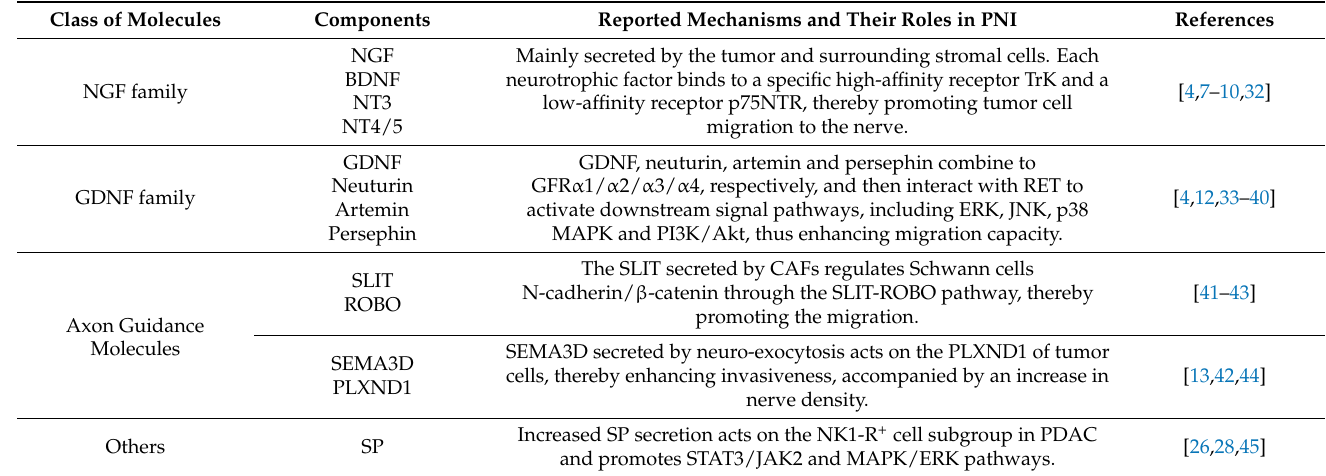
Table 2. Typical nerve-related factors involved in